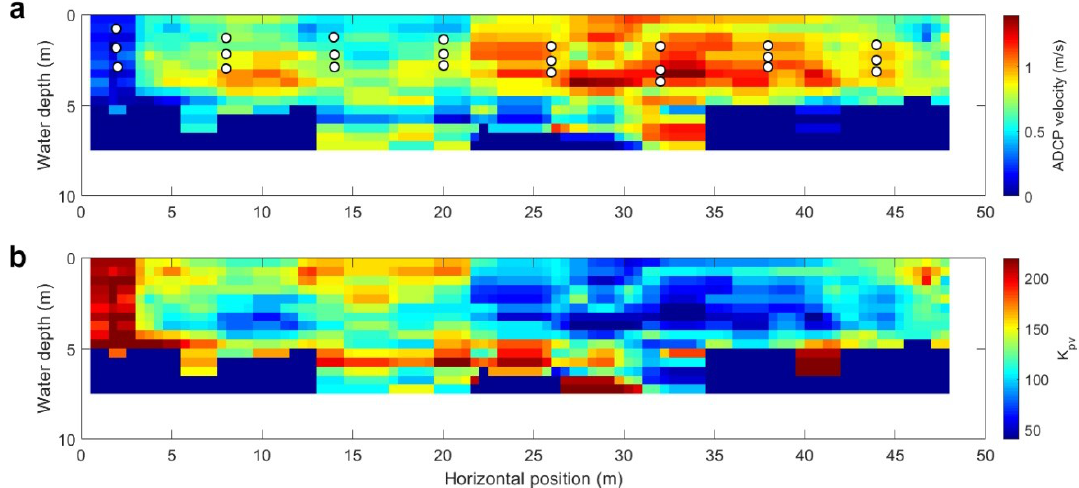
Figure 10. Cross-section plots of the bulk velocity (in profile 189) measured by the ADCP, the locations of the 24 DBox measurements are shown as white circles with a black border ( a ). The plot of the pressure turbulence by combining the differential pressure fluctuations and bulk velocity measurements following Equation (2) ( b ). Note the linear relationship between the bulk velocity and turbulence (dynamic pressure coefficient). Thus, the spatial distribution of the intensities was found to be inversely proportional for this case study. At Kirchbichl, regions with high Kpv had on average, lower flow velocities.